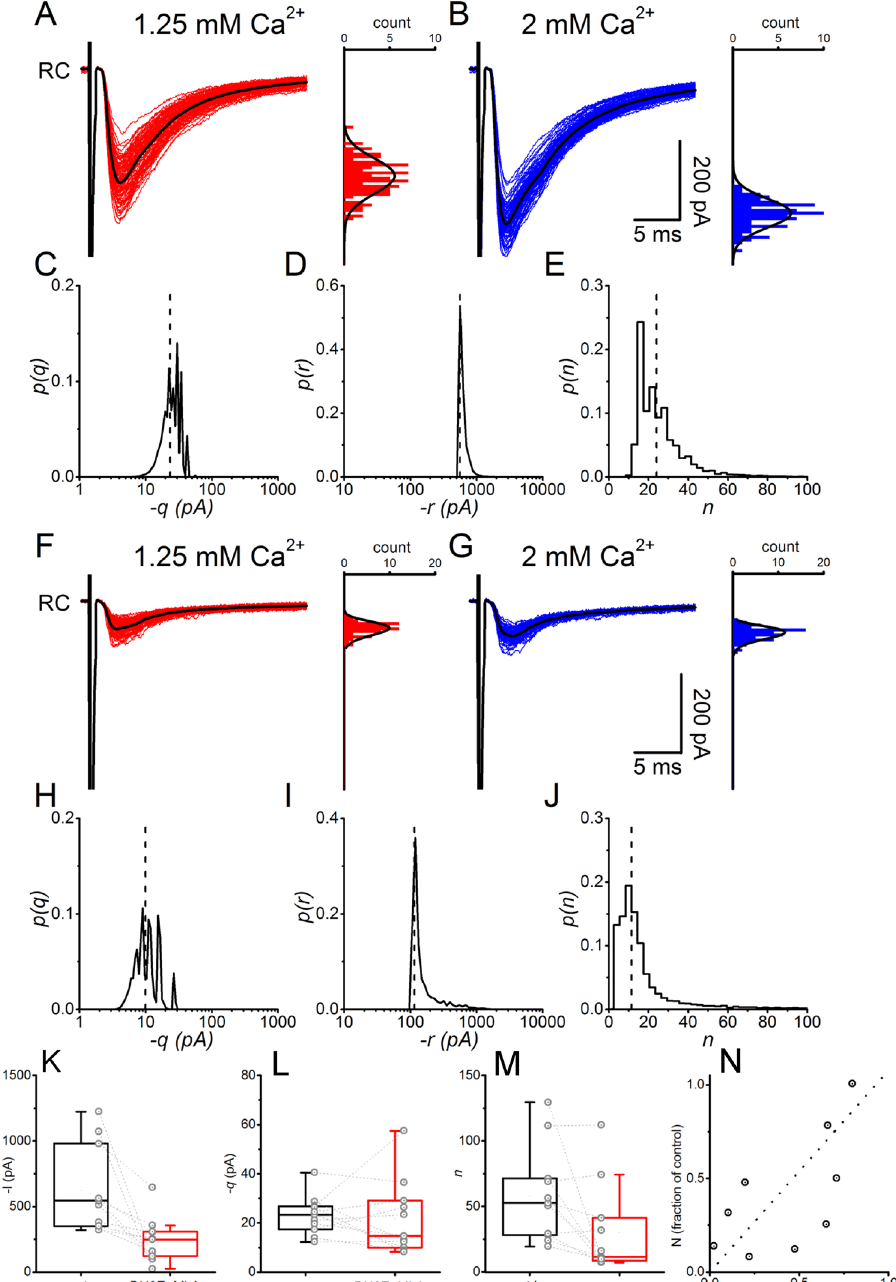
Figure 7. Effects of cholinergic antagonists on the quantal parameters of evoked EPSCs. Responses to VR stimulation in a RC are shown in panel A and B in two different conditions of release probability. Posterior probability distribution of the quantal parameters calculated by BQA are shown for q (panel C), nq (panel D) and n (panel E). The vertical lines indicate the position of the median of the distributions. The amplitude distribution histograms for each Ca 2 + concentration are overlaid with the theoretical distributions calculated from the estimate of the quantal parameters ( A and B ). Following block of the cholinergic component, the evoked EPSCs were again recorded using the same two Ca 2 + concentrations as in control. The responses are largely reduced ( F and G ) and the probability distributions of the quantal parameters ( H , I , J ) show that the number of release sites is reduced in the presence of the antagonist (median values indicated by a vertical line). Pooled data of the mean evoked current in control and following block of nicotinic receptors show a substantial reduction in the responses ( K ). While the difference in quantal size was not significant in the two conditions ( L ), the number of release sites was significantly reduced following block of nAChRs ( M ). The extent of change in the number of release sites is strongly linearly correlated with the fraction of the eEPSCs mediated by nAChRs ( N